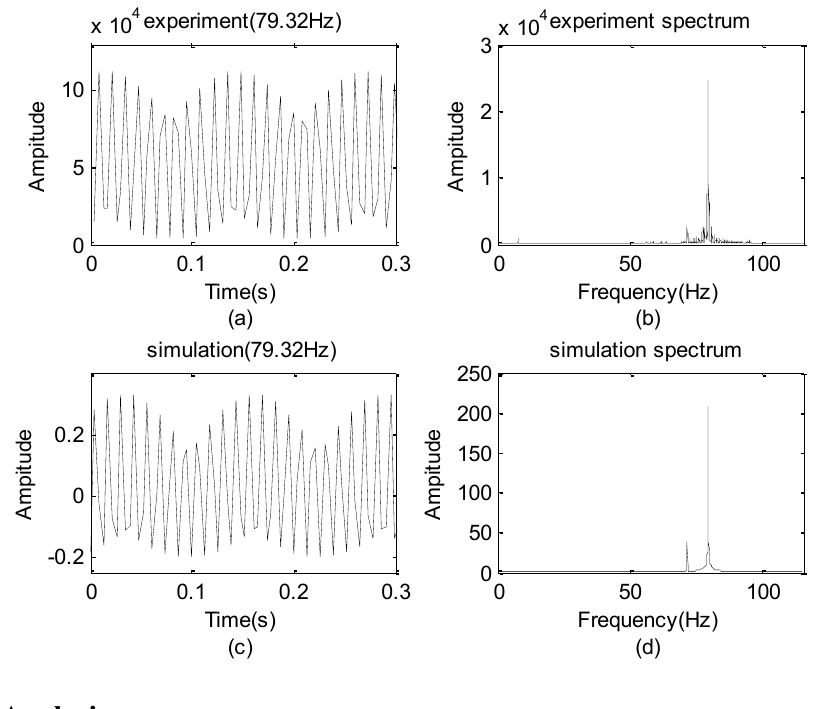
Figure 6. Comparison between experimental and modeled data: ( a ) data of the experiment; ( b ) spectrum of experiment; ( c ) data of simulation; and ( d ) spectrum of